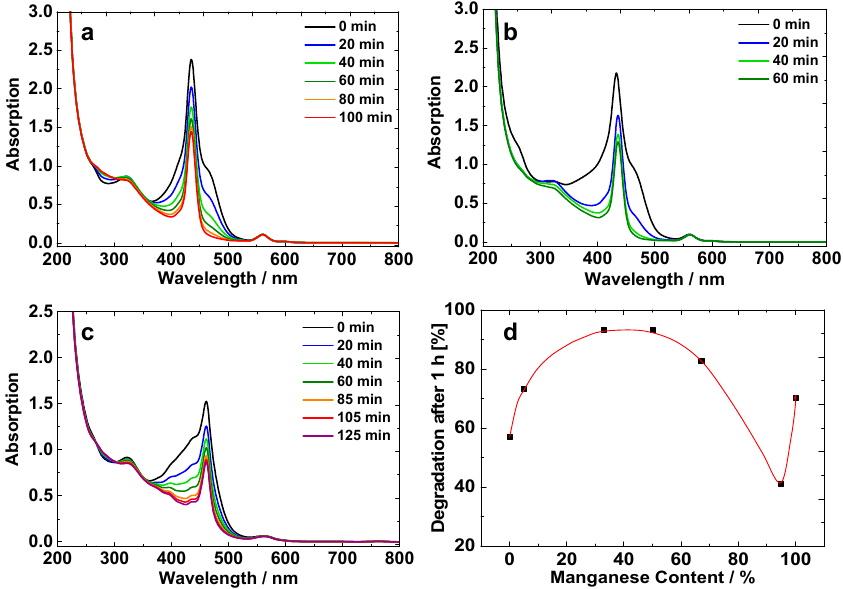
Figure 4. Photocatalytic model reaction of crocin with ( a ) CdS–Zn 0.95 Mn 0.05 -TAPP, ( b ) CdS- Zn 0.33 Mn 0.67 -TAPP, ( c ) CdS–Zn 0.05 Mn 0.95 -TAPP and ( d ) dependence of degradation rate on the manganese content in the shell.